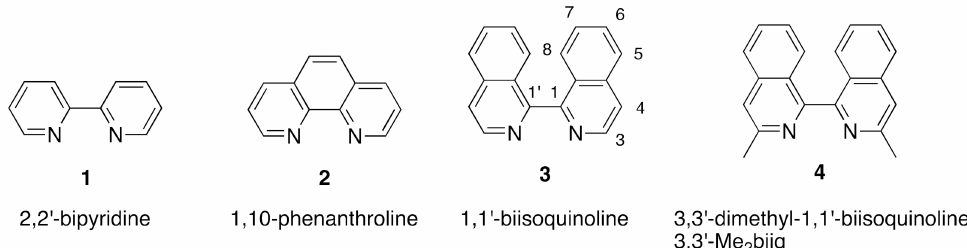
Figure 1. The structures of the „parent” heterocyclic diimines 2,2 (cid:48) -bipyridine ( 1 ) and 1,10- phenanthroline ( 2 ) together with that of 1,1 (cid:48) -biisoquinoline ( 3 ), the subject of this review. The IUPAC numbering scheme for derivatives of 1,1 (cid:48) -biisoquinoline is indicated and also shown is